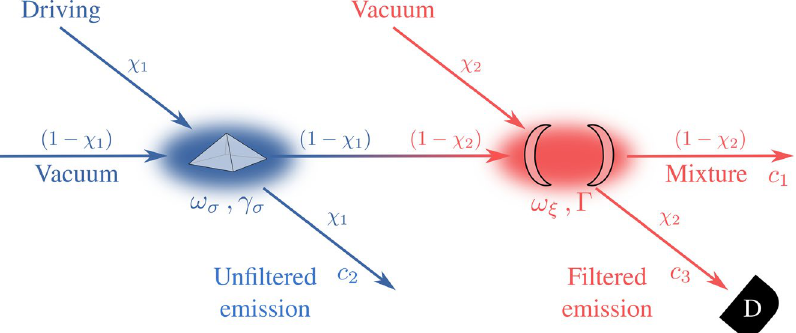
Figure 1. Scheme of the setup to measure the frequency-resolved correlations of the light emitted by a source, whose energy is centered at ω σ and has a decay rate γ σ . While a fraction of the emitted light goes unfiltered to the open space, to which we refer to as the “unfiltered emission” and which is described by the quantum jumps of the operator c 2 in Eq. (7), the remaining fraction is used to weakly drive the sensor, which has frequency ω ξ and decay rate Γ , which is also the bandwidth of the sensor. The emission from the sensor can also be separated into two streams, depending on whether the emission from the sensor is mixed or not with scattered light from the source (e.g., the emission of the sensor and the scattered light might follow different spatial paths). The case without the scattered light corresponds to the “filtered emission” which can then go to a detector D or a Hanbury Brown-Twiss setup. It is associated to the operator c 3 of Eq. (7), while the mixture of light is described through the operator c 1 of Eq.